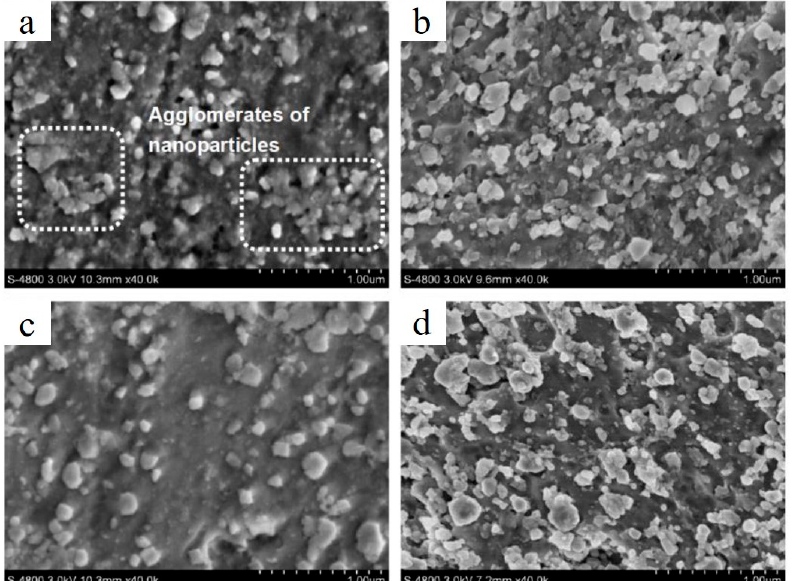
Figure 7. SEM images portraying dispersion degree of TiC and respective microstructure of fabricated AlSi10Mg/5 wt.%TiC composite processed at various E l (E v ): 314 J/m (125.71 J/mm 3 ) ( a ), 440 J/m (176.0 J/mm 3 ) ( b ), 733 J/m (293.3 J/mm 3 ) ( c ) and 1100 J/m (440.0 J/mm 3 ) ( d ) (reproduced with permission from [70]).